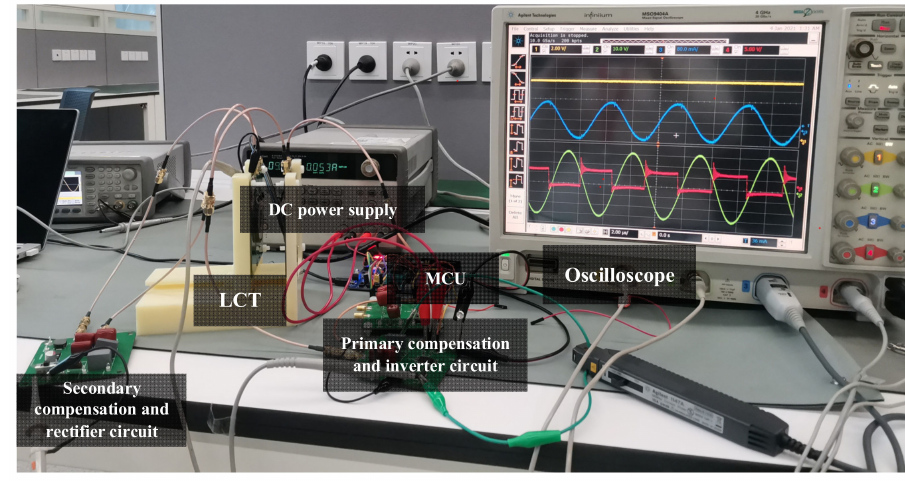
Figure 33. S/LCC compensated IPT prototype. Figure 34 is the voltage waveforms of the primary coil and the secondary coil.